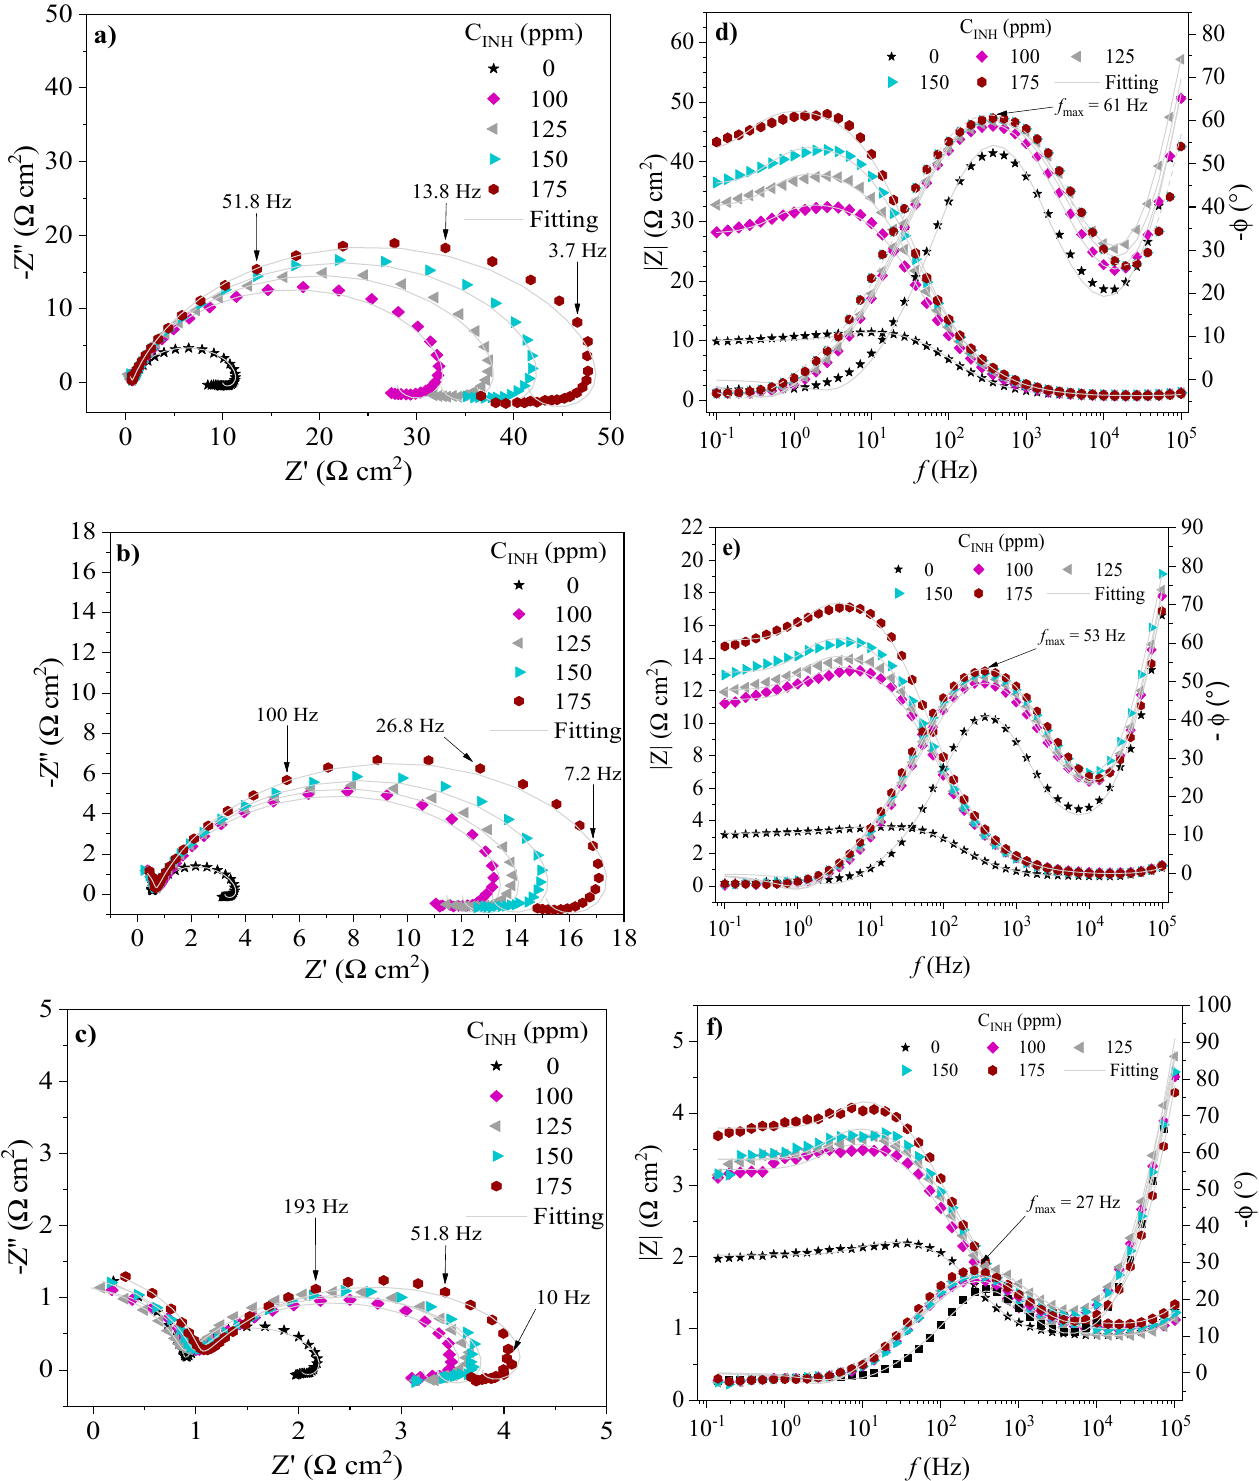
Figure 8. EIS spectra of API 5L X60 steel in 1 M H 2 SO 4 in the presence of Poly[VIMC2][Br]: Nyquist [( a ) 308 K, ( b ) 318 K and ( c ) 328 K] and Bode [( d ) 308 K, ( e ) 318 K and ( f ) 328